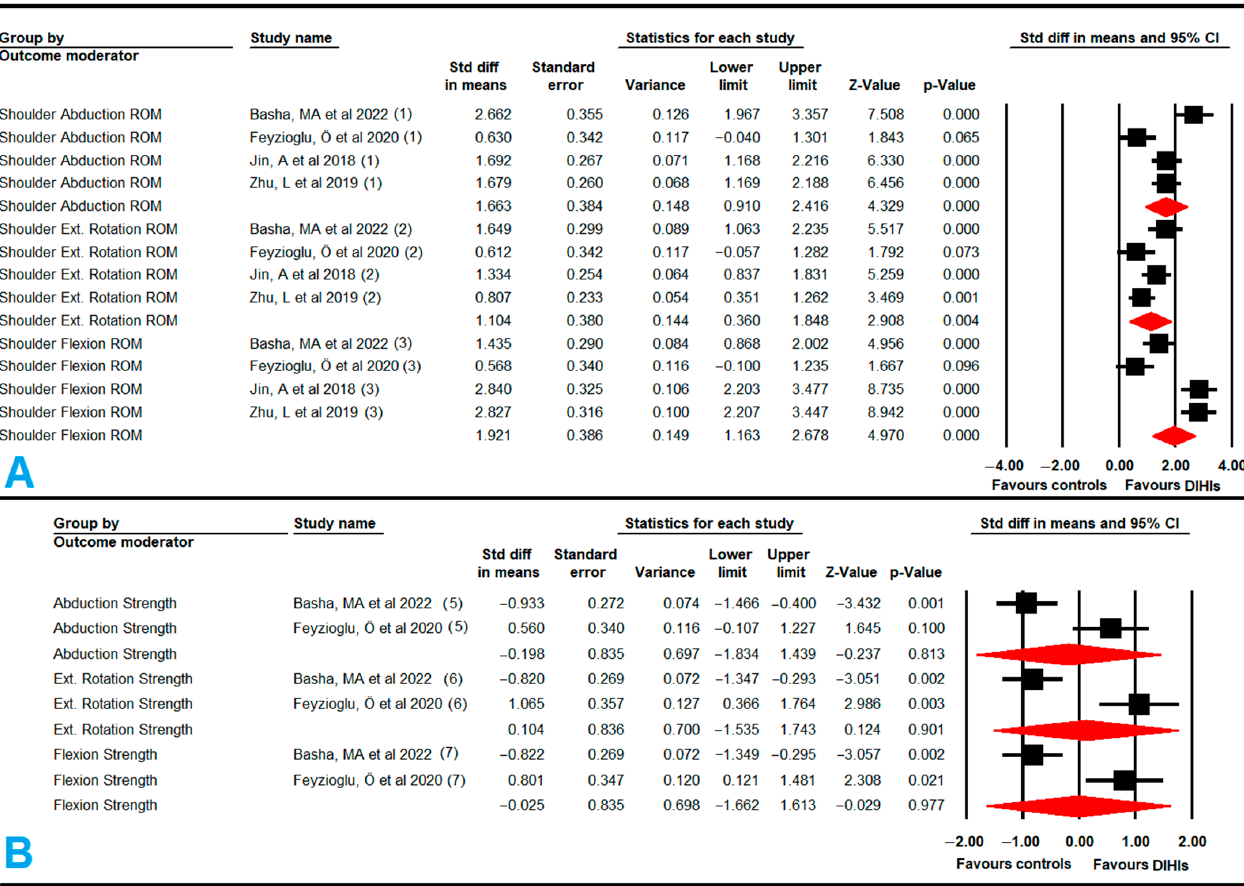
Figure 3. Forest plot of the effect of DIHIs on shoulder range of motion ( A ) and shoulder strength movements ( B )